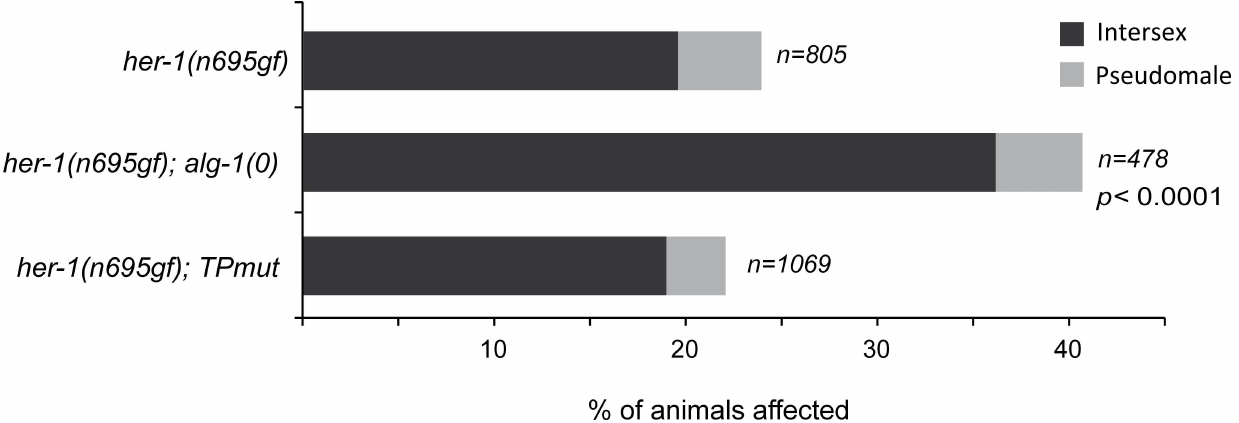
Fig 6. The embryonic sex determination controlled by the mir-35 microRNAfamily does not require an AIN-containing miRISC. The fraction of animalsdisplayingpseudomale and intersex phenotypesin the her-1(n695gf) , her-1(n695gf); alg-1(0) and her-1(n695gf); alg-1 (TPmut) populationwere scored. The number of animalsscored (n) for each geneticbackgroundis indicated.The two-tailed p values indicated were measuredby Fisher’s exact